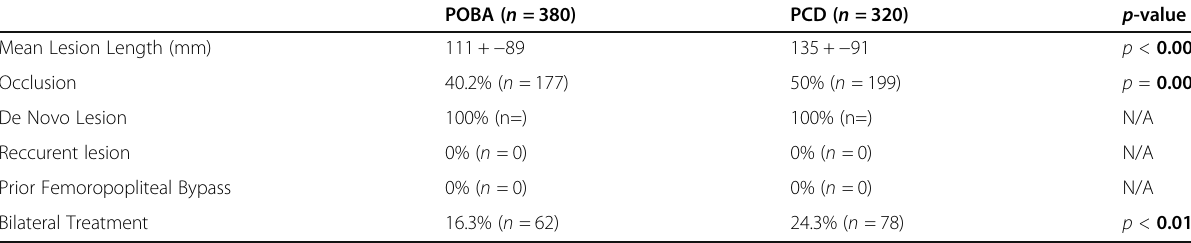
Table 3 Characteristics of the femoropopliteal lesions in both PCD and POBA